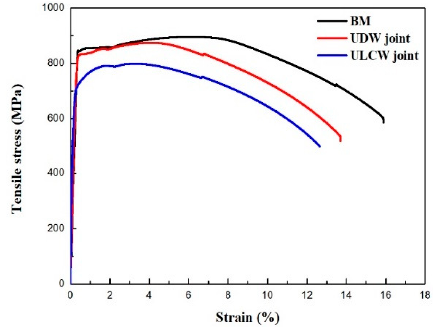
Figure 10. Tensile stress–strain curves of the base metal and welded joints. Table 4. Tensile properties for the base material, the UDW joint and the ULCW joint. Test Specimens Yield Strength (MPa)